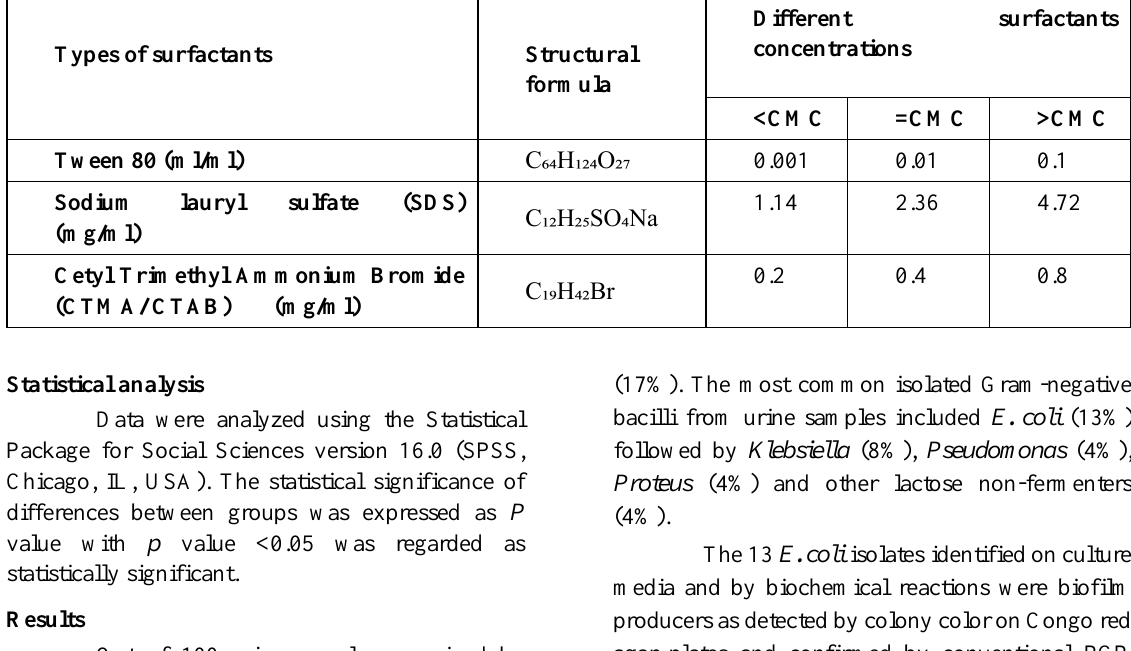
Table 1. Surfactant structural formula and